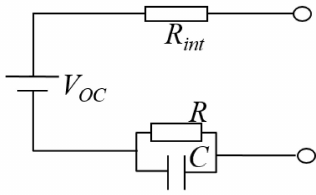
Figure 2. The Thevenin equivalent circuit model.